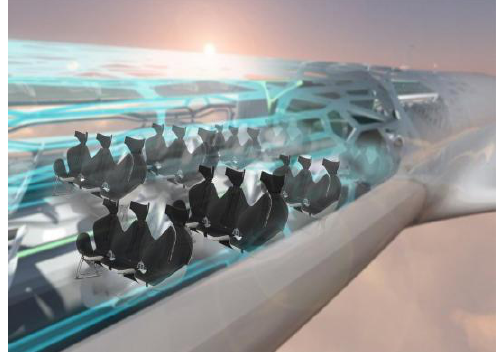
Figure 4. 3D modeling design.